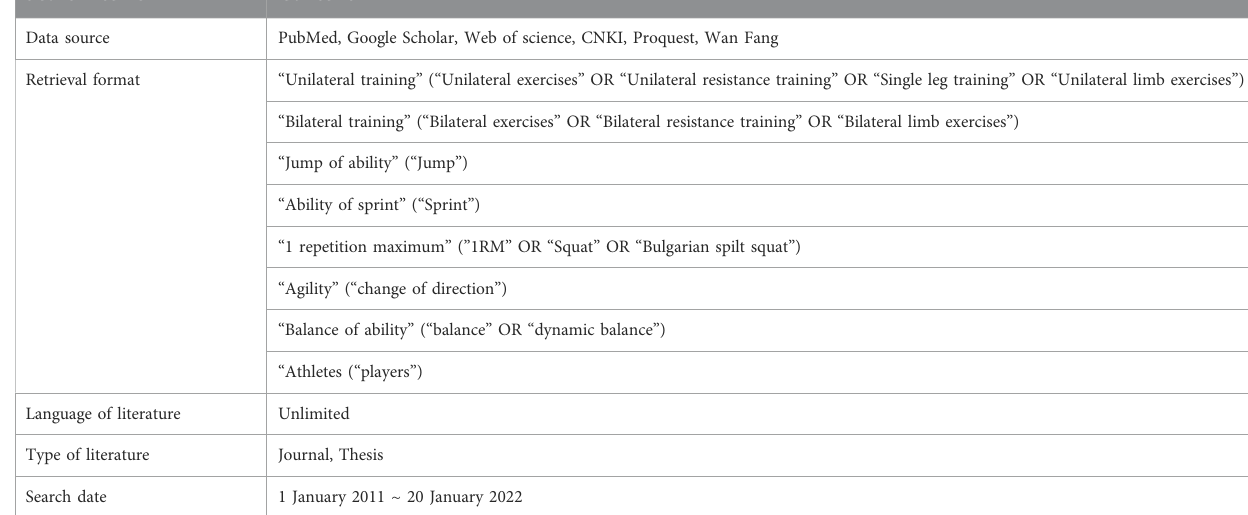
TABLE 1 Literature search criteria